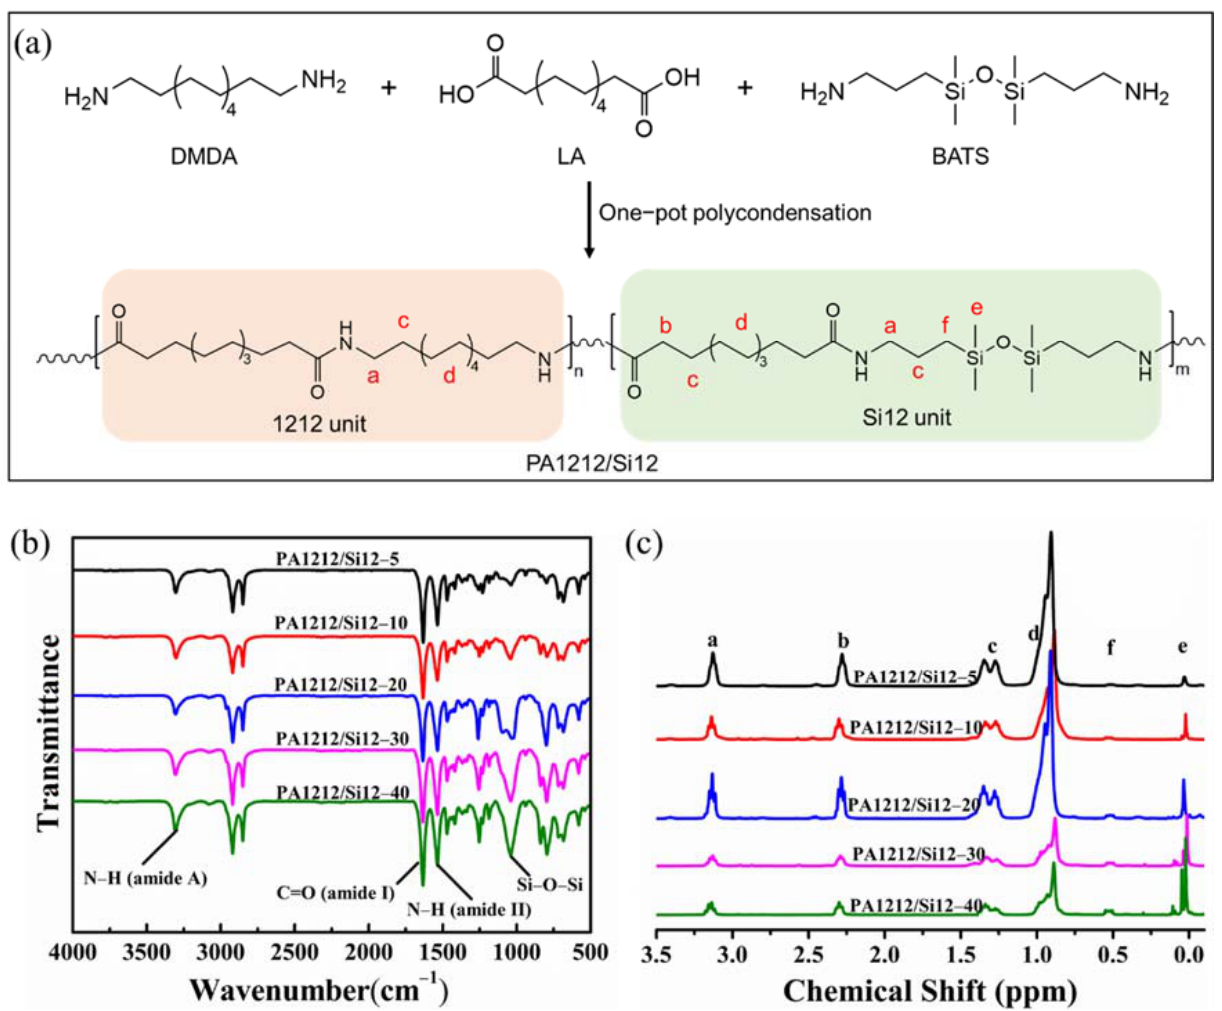
Figure 1. ( a ) One–pot polycondensation route of PA1212/Si12 copolymers; ( b ) FTIR and ( c ) 1 H NMR spectra of PA1212/Si12 copolymers.